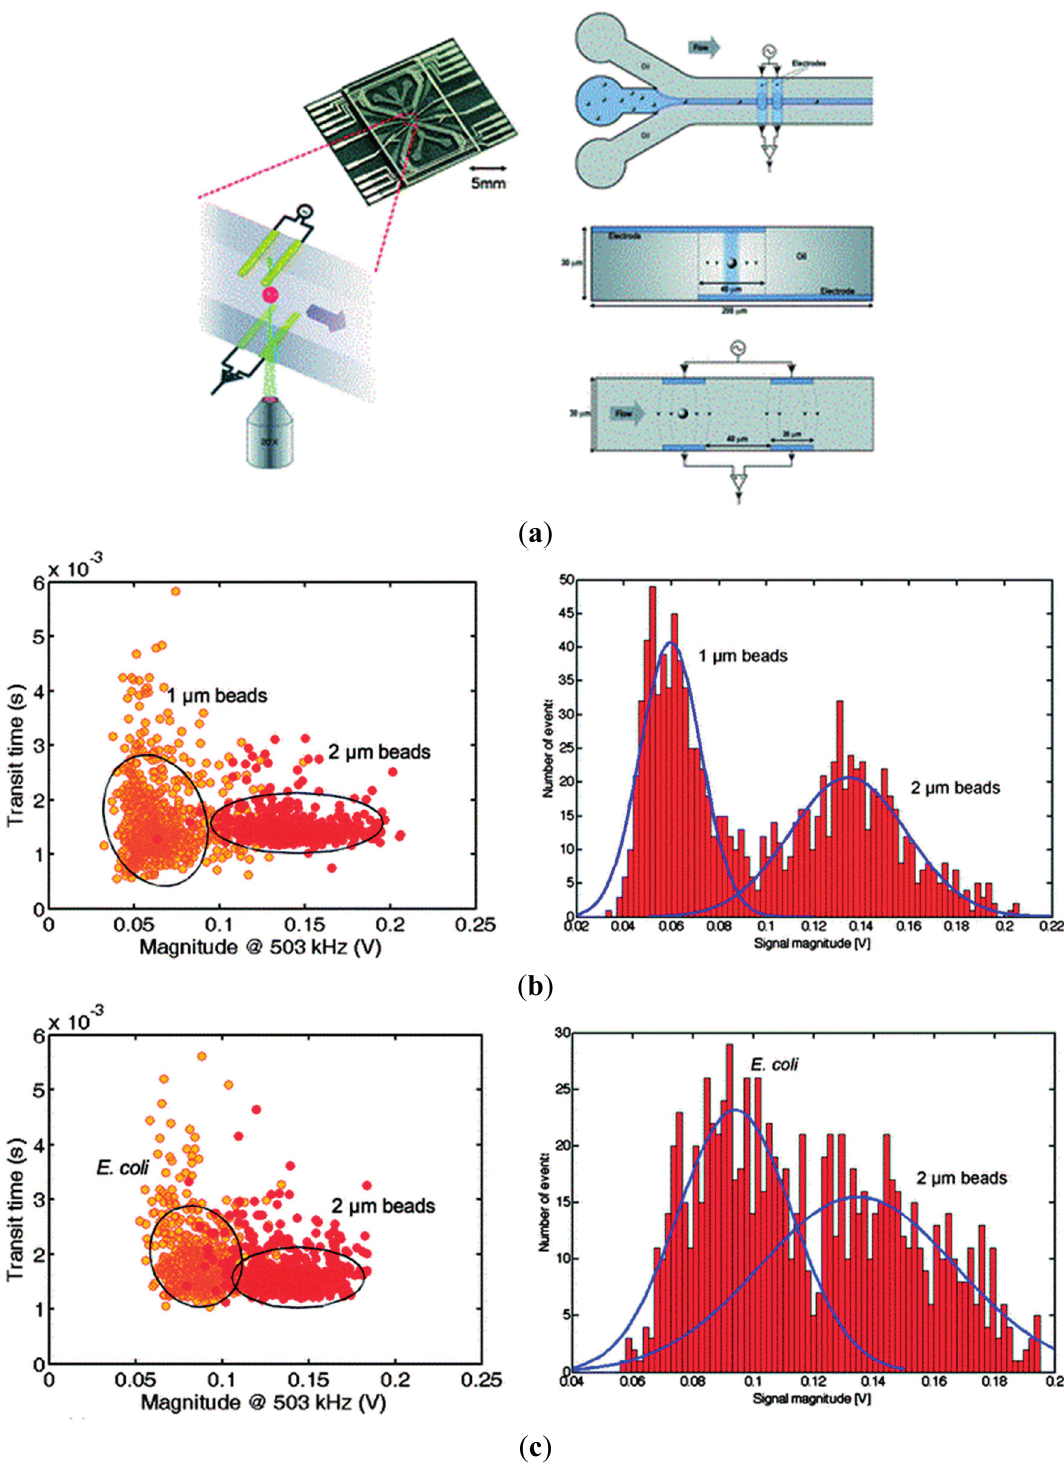
Figure 3. ( a ) A microfluidic impedance flow cytometer uses an insulating fluid to hydrodynamically focus a sample stream of cells suspended in electrolyte through the sensing area of two microelectrodes; ( b ) Successful classification of 1 and 2 μ m diameter polystyrene beads based on impedance amplitudes at 503 kHz; ( c ) As to the classification of 2 μ m diameter polystyrene beads and E coli (~2 μ m in length and 0.5 μ m in width), a significant overlap in the impedance amplitude histogram at 503 kHz was observed